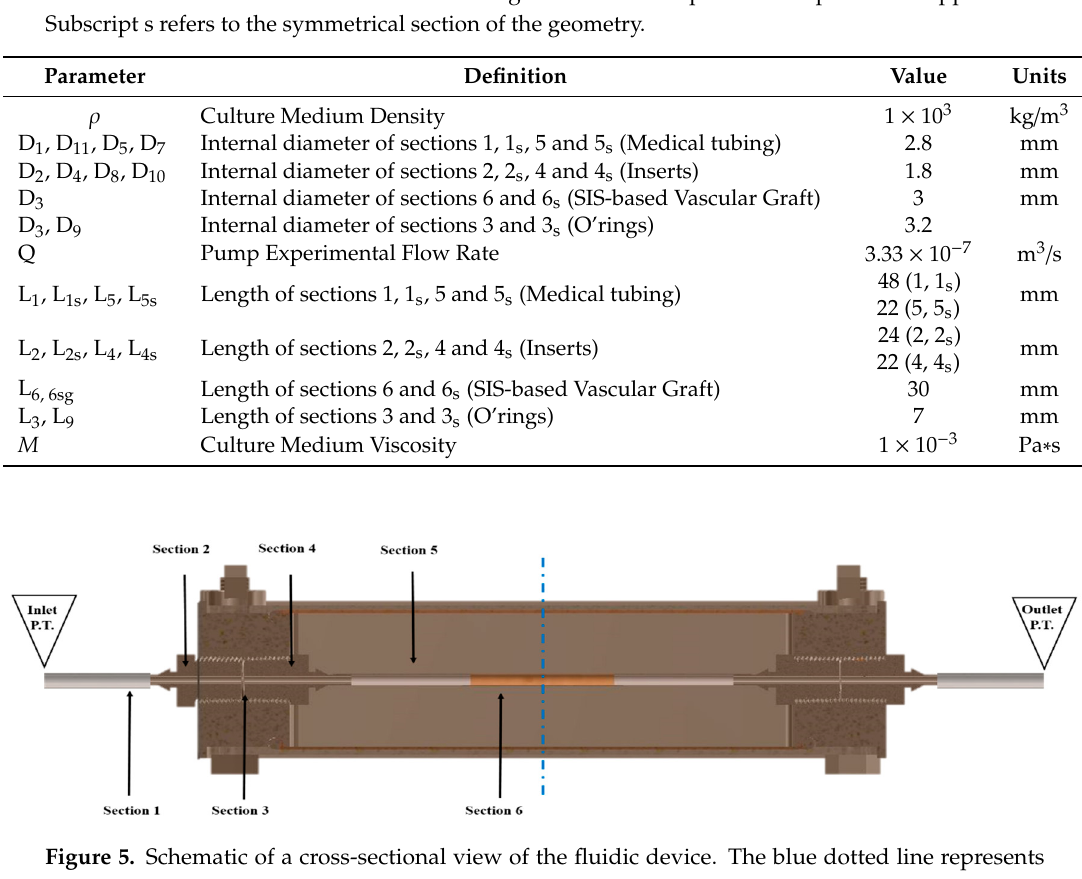
Figure 5. Schematic of a cross-sectional view of the fluidic device. The blue dotted line represents the symmetry on sections and dimensions (subscript s in the Table 1). Section 1 corresponds to the medical tubing of length L 1,1s from the inlet and the outlet pressure transducers, respectively. Sections 2 and 4 represent the four inserts to connect the required medical tubing sections (L 2,4,2s,4s ). Section 3 represents the internal O-rings distance (L 3,3s ). Section 5 corresponds to the medical tubing used to connect the vascular graft to the fluidic device (L 5,5s ). Section 6 represents a half-length SIS-based vascular graft of length L 6,6s (i.e., Total length of the SIS-based vascular graft is two-times L 6 ). Equation (6) was used to calculate the minor local pressure losses while Equations (7) and (8)